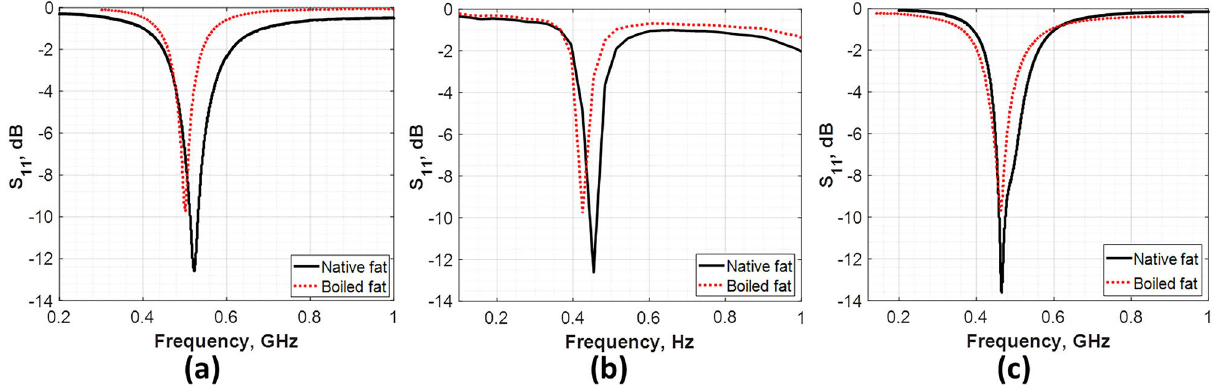
Figure 6. The measured reflection coefficient (S11) of the three fabricated antennas for native and boiled fat